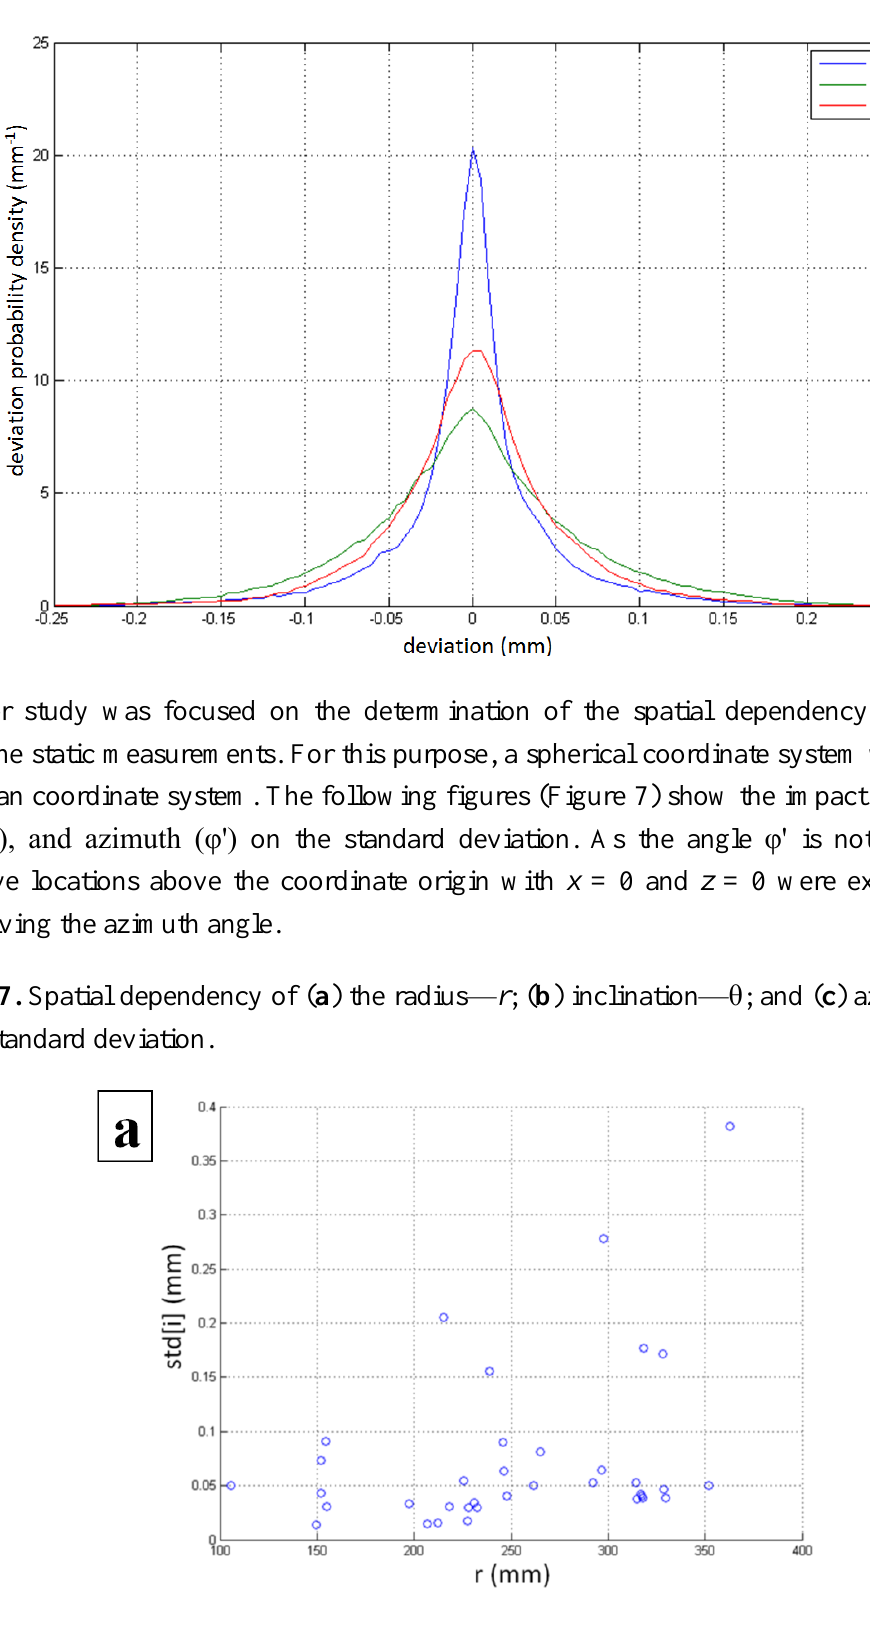
Figure 6. The probability density of the deviations, including all 37 locations.